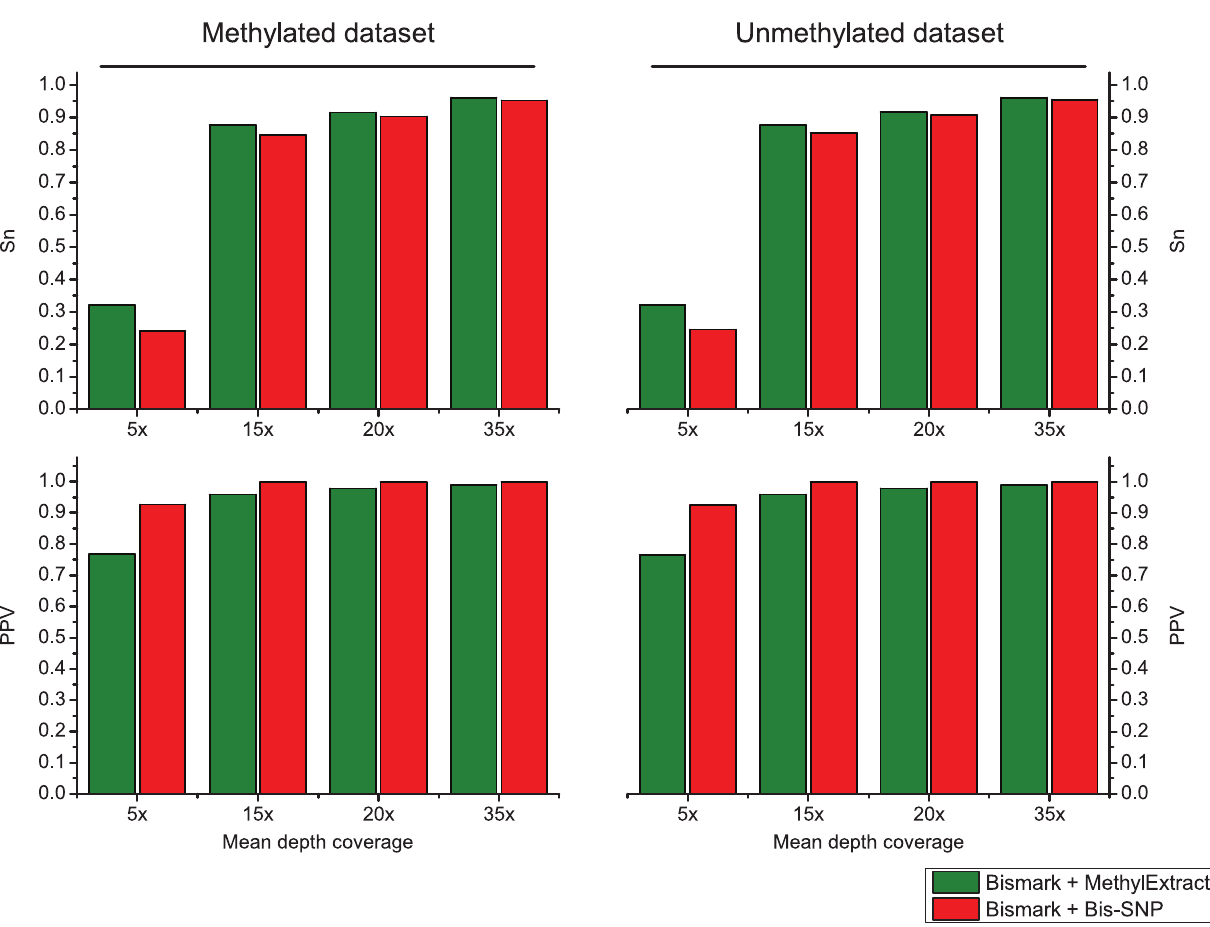
Figure 6. Comparison of SNV calling between MethylExtract and Bis-SNP . The top graph shows the sensitivity (Sn) and the bottom graph the specificity (PPV) obtained for the methylated and un-methylated artificial bisulfite datasets at two different mean coverages (5×, 15×, 20× and